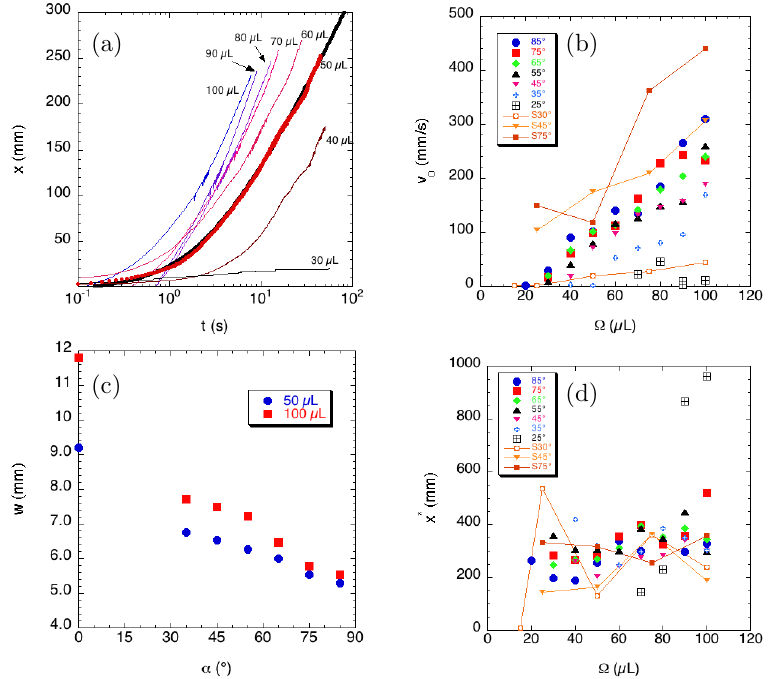
Figure 7: Water droplet – (a) Position of the droplet as a function of time (semi-log) for eight droplet volumes between 30 and 100 µ L (see legend) for an inclination of 45 ◦ . The solid line is the fit of Eq. (2) on the data Ω =50 µ L. (b) The initial speed v 0 of the droplet is reported as a function of the volume Ω for different angles α between 25 and 85 ◦ . The data points linked by solid lines correspond to the smooth side of the glass for three inclination angles: 30, 445 and 75 ◦ (see legend). (c) Width w of the water droplet wake as a function of the inclination angle for two droplet volumes (50 and 100 µ L). (d) Dependence of the parameter x (cid:63) = a 1 as a function of droplet volume. The same parameters and symbols are used as in Fig.